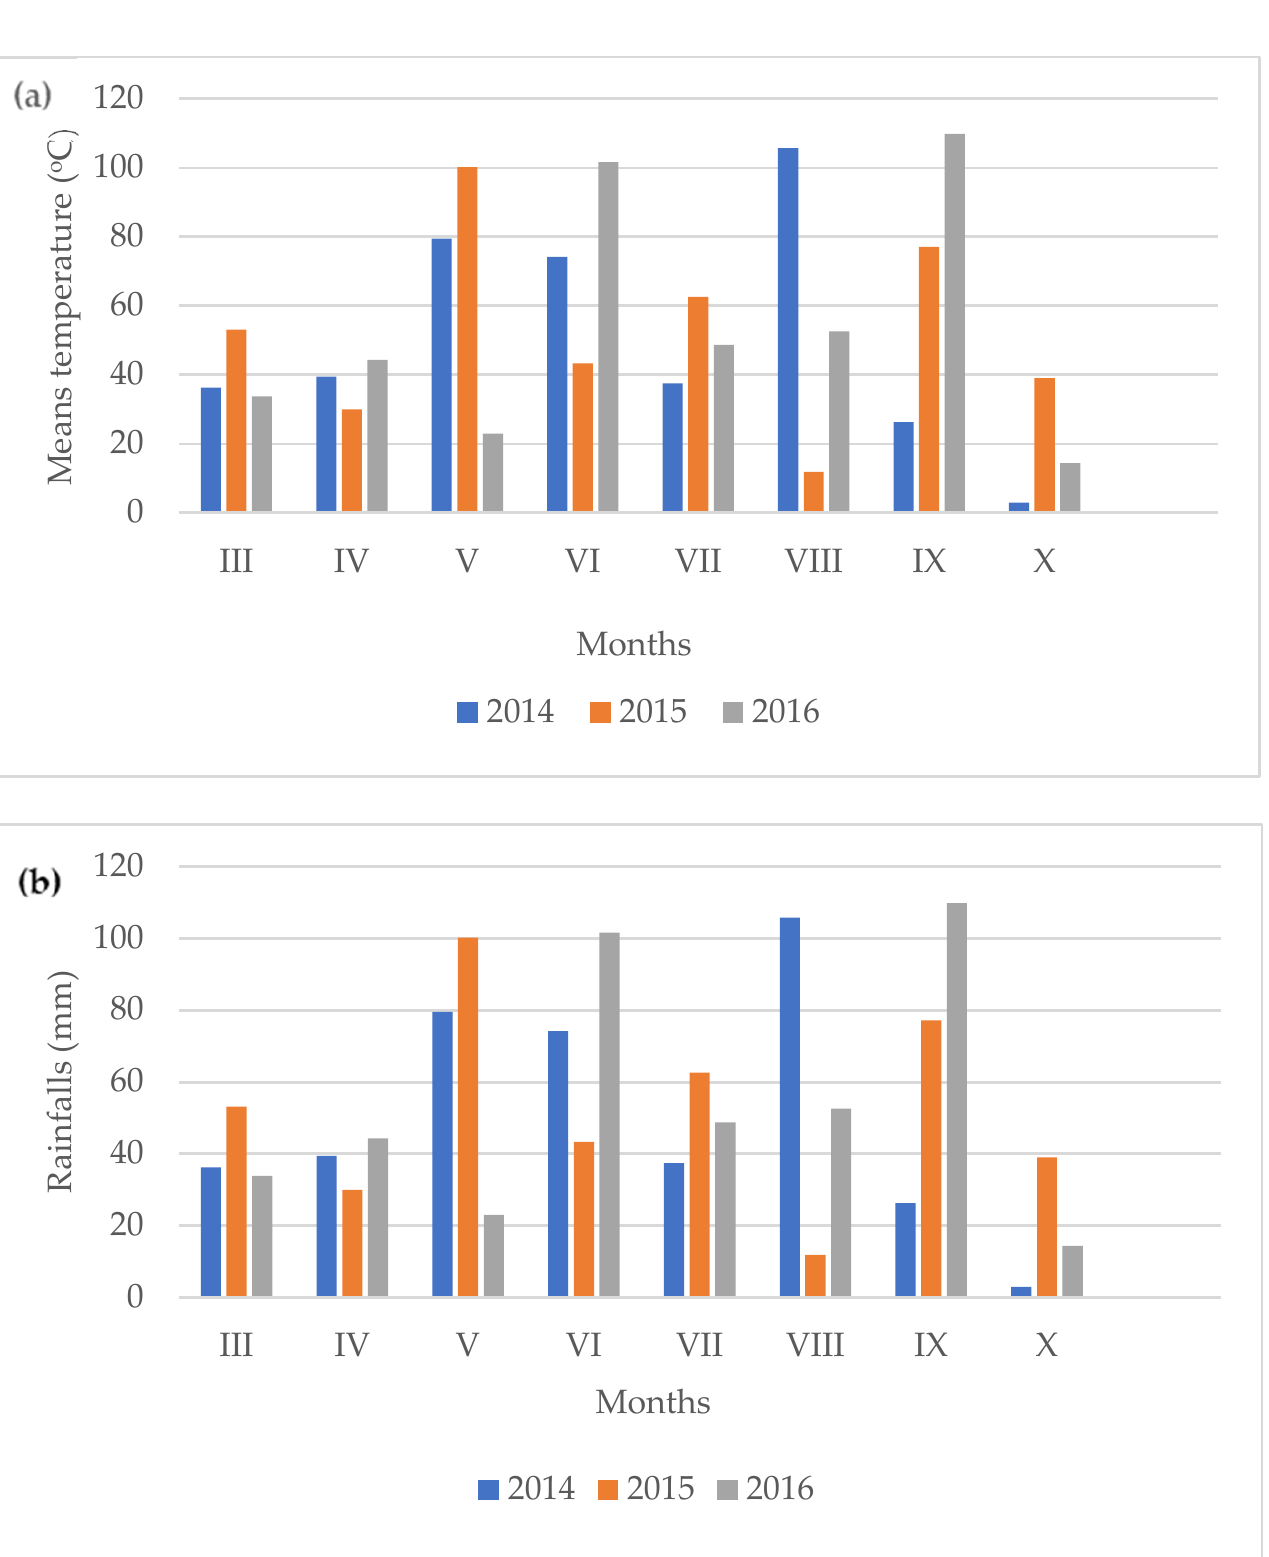
Figure 2. The air temperature ( a ) and rainfall ( b ) during vegetation period noted by Hydrological and Meteorological Station in Siedlce (Poland).